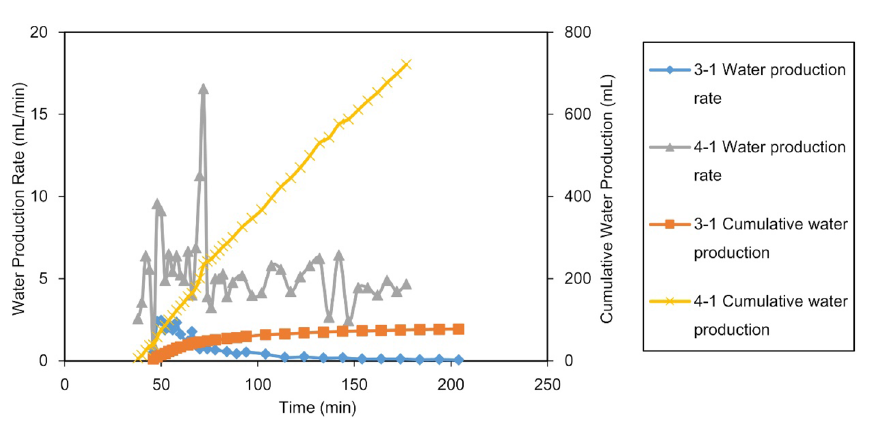
Figure 20. Water production of Gas Well 2 in the FZ of Experiments 3-1 and